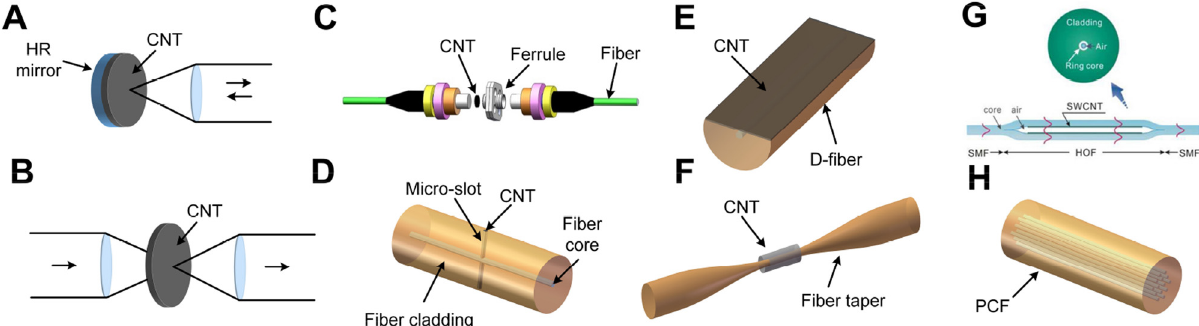
Figure 2: Schematic diagram of the CNT mode-locking device: (A – D) Transmission type; (E) – (F) evanescent field type; (A) Reflection type; (B)transmissiontype;(C)fiberferruleintegratedtype;(D)microfluidicchanneltype,Martinezetal.[31].©OpticalSocietyofAmerica2008.(E) BasedonD-type fi ber,Songetal.[32].©OpticalSocietyofAmerica2006;(F)basedonmicro/nano fi ber,Songetal.[33].©AmericanInstitute of Physics 2007;(G)Based onhollow fi ber,Choi etal. [34]. © OpticalSocietyof America2009;(H) Basedonholey fi ber. Obraztsova et al. [35]. © John Wiley & Sons, Inc